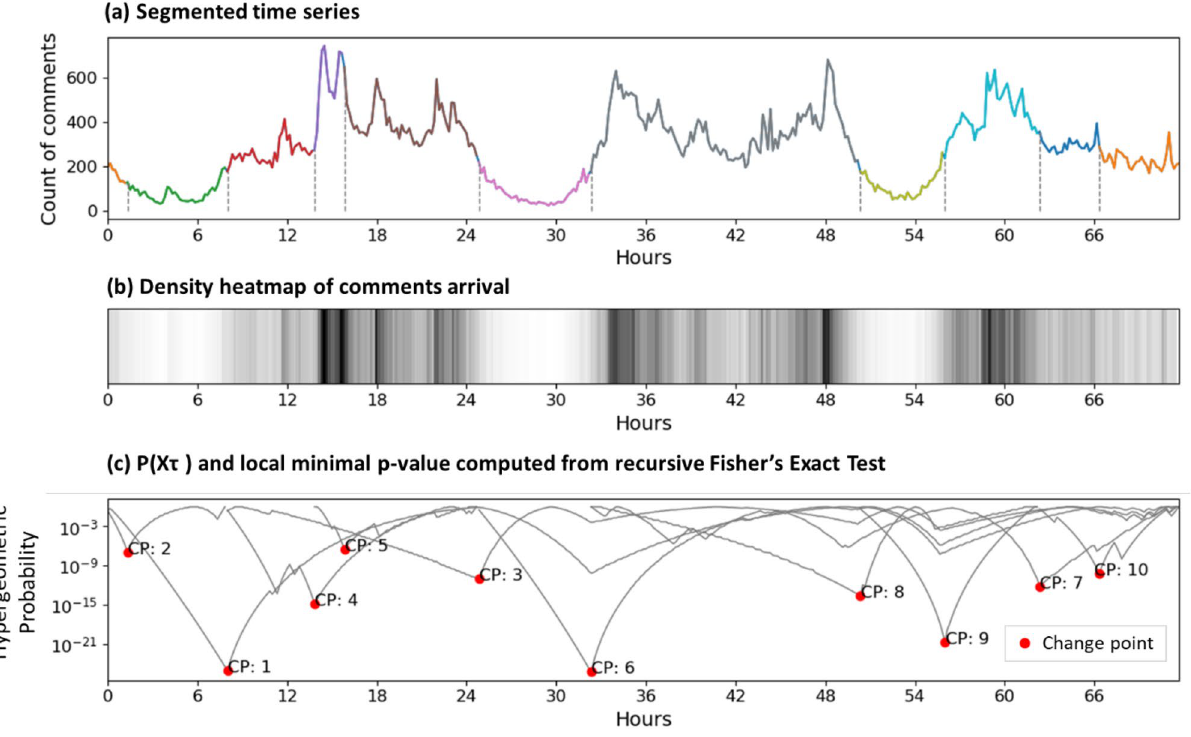
Figure 3. Time series segmentation using the Fisher’s Exact Test. ( a ) An example of segmentation result using proposed Fisher’s Exact Test. The x-axis is the timestamp (unit time 600 s) and the y-axis is the count of comments. Each segmented section is shown in different colors and separated using dashed lines. ( b ) is the corresponding comment’s arrival density plot of ( a ). It shows that the originally uneven and clustered distribution of arrival can be segmented into sections with similar comment arrival density. ( c ) Results of the process of recursive Fisher’s Exact Test for detecting multiple change points in a time series. The hypergeometric probability is calculated using Eq. (5) for each sub-segment. The minimum hypergeometric probability value of each segment is taken as the p-value . The p-value is then compared to a threshold p th to determine if the time point t is small enough to be considered as a change point υ . If yes, the sub-segment will be cut into 2 sub- segments at the change point υ . Then the same process will be repeated until the p-value of all sub-segments are larger than the threshold. The data label CP:i refers to the change point detected in the i th